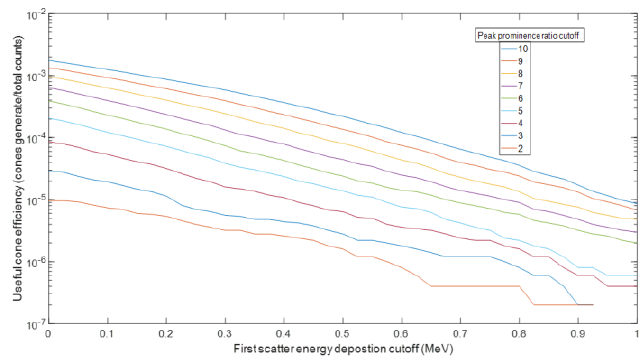
Fig. 15. Useful cone efficiency curves for the camera system